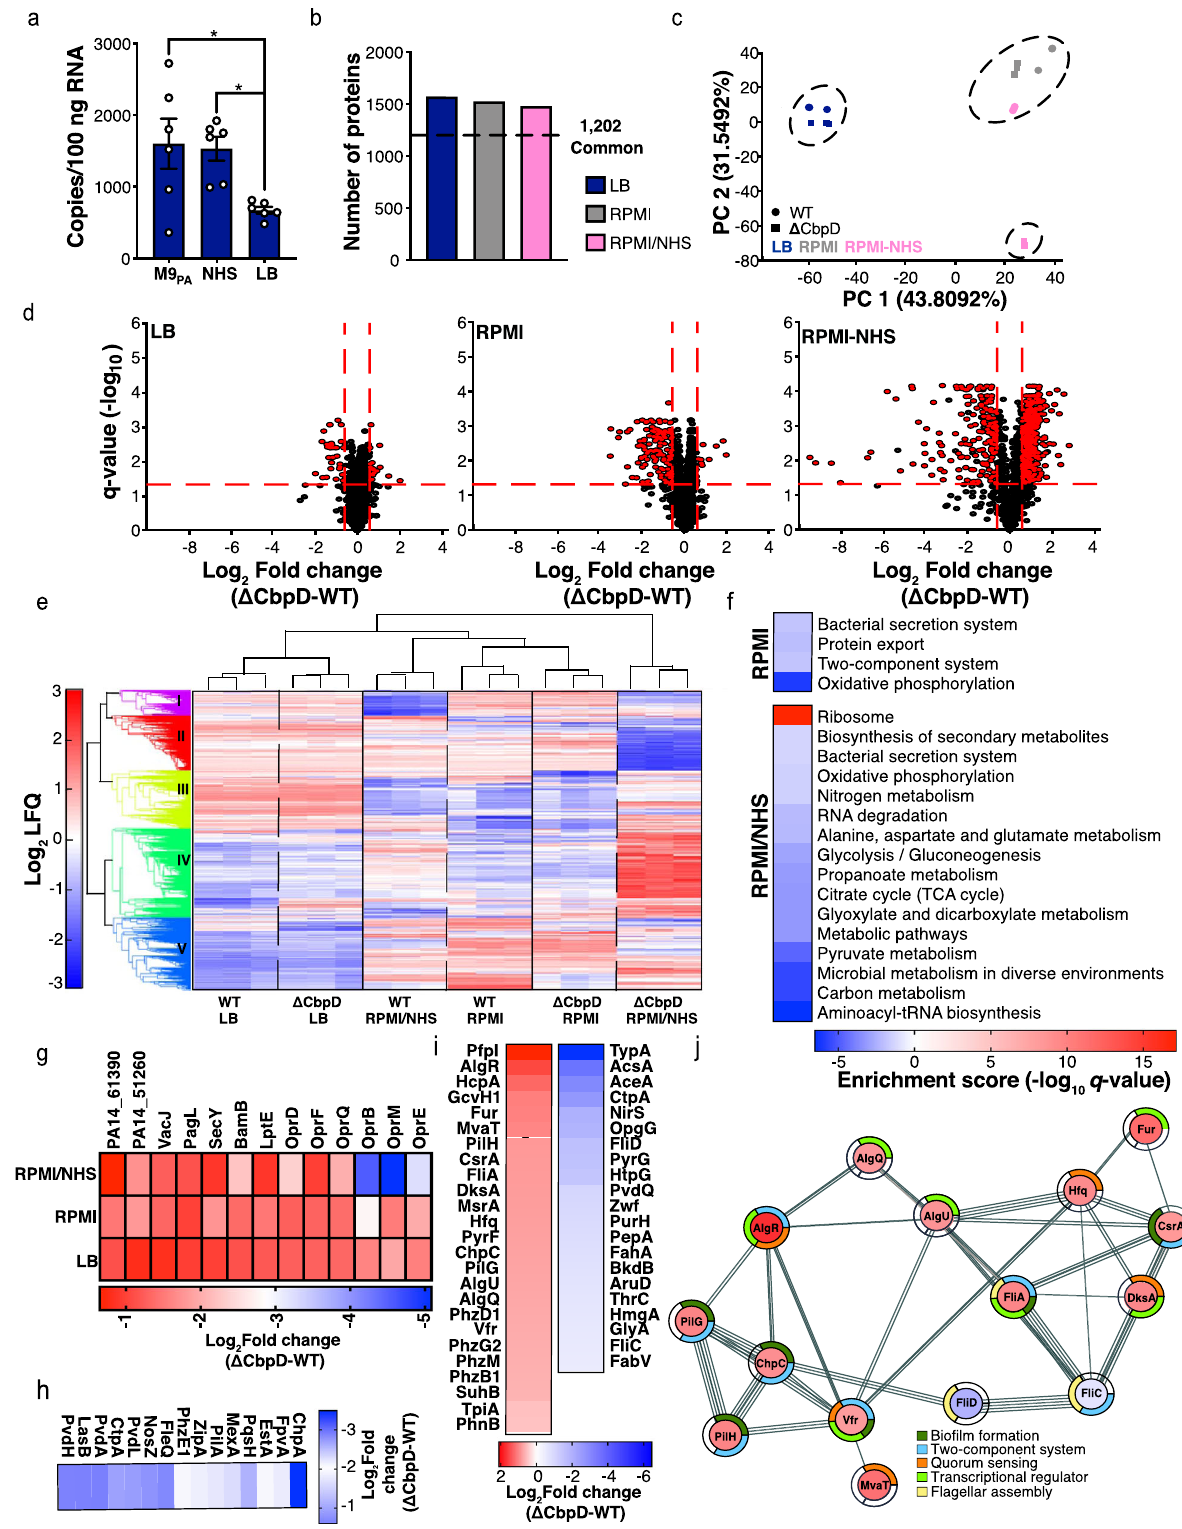
resulted in signi fi cant differential regulation of 589 proteins in Δ CbpD vs. WT (Fig. 2d, right panel), compared to a more modest number of differentially expressed proteins in LB ( n = 50) (Fig. 2d, left panel) or RPMI ( n = 136) (Fig. 2d, middle panel). KEGG Pathway enrichment analysis of the differentially regulated proteins ( Δ CbpD vs. WT) revealed that loss of CbpD